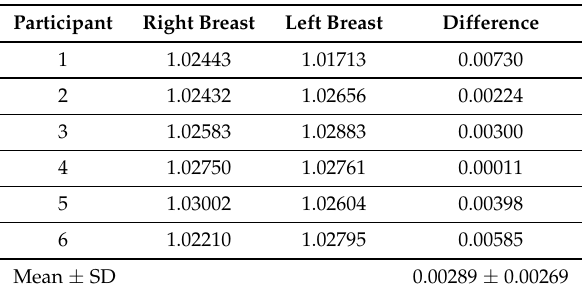
Table 6. Human milk, after thawing from the same participant but different breasts, shows differences in ρ (g cm − 3 ) at 37 ◦